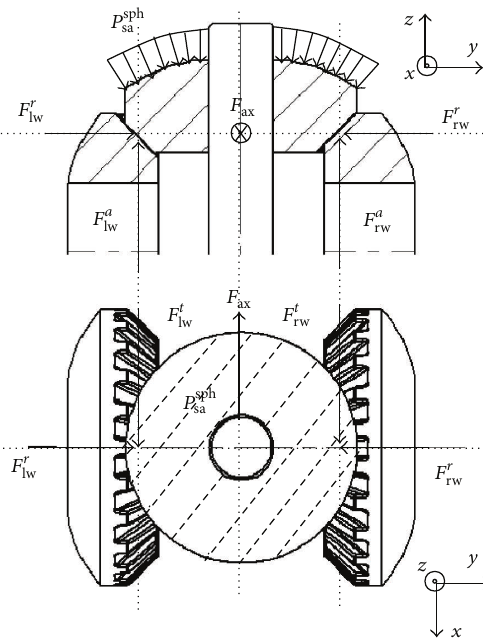
Figure 7: Forces applied to a satellite